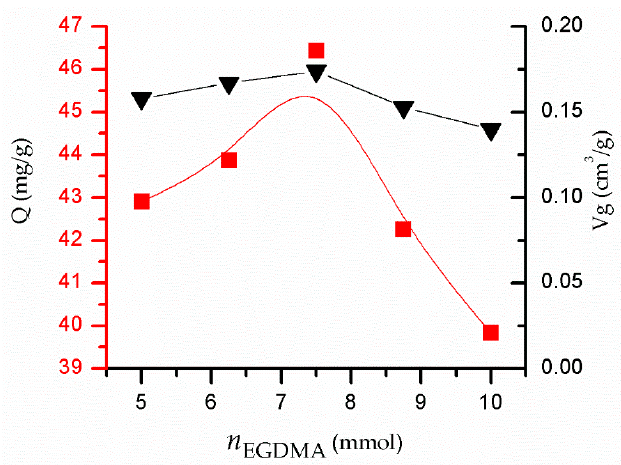
Figure 7. The influence of n EGDMA on the adsorption performance of SSO-MIPs and pore volume.